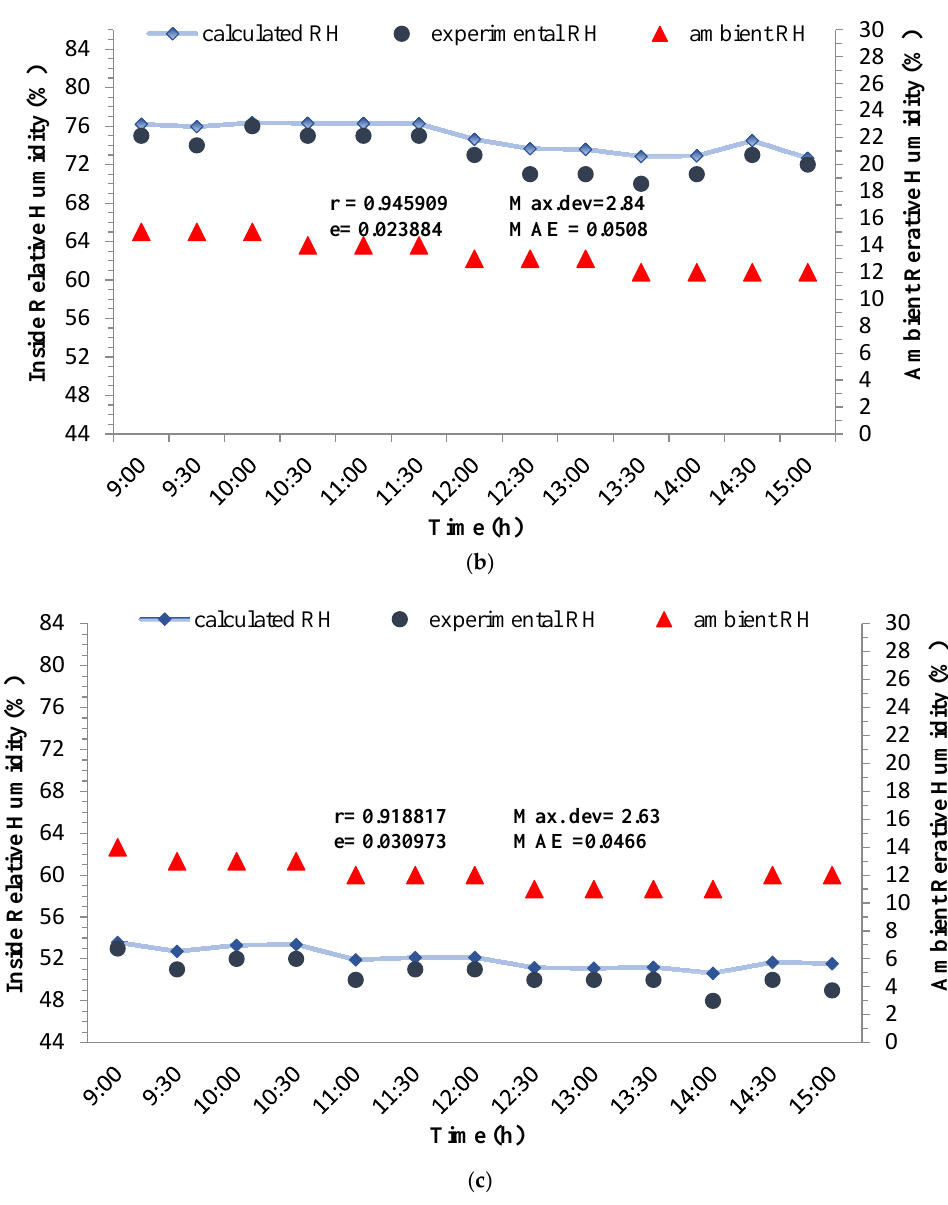
Figure 4. Hourly variations of experimental and calculated outlet air relative humidity under the conditions of Qaen city during 3–5 May 2017, at the air speeds of ( a ) 1, ( b ) 1.5, and 2.5